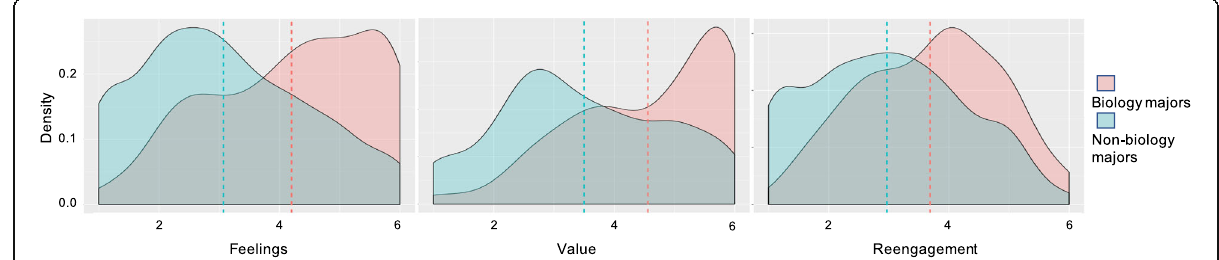
Fig. 2 Density plots on mean scale scores for feelings, value, and reengagement for biology majors and non-biology majors. Dashed line indicated mean “ mean scale score ” for biology and non-biology